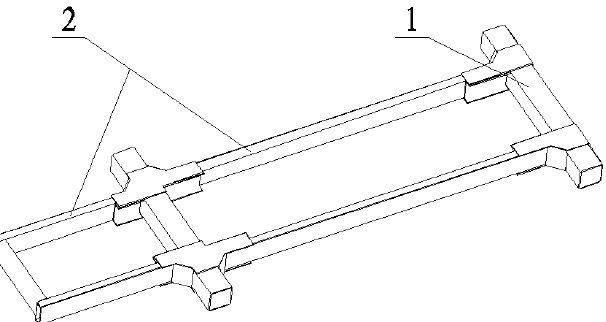
Figure 2. Disconnected longitudinal beam side beam type frame. 1. Axles (crossbeams) 2. Discon- nected longitudinal beam.